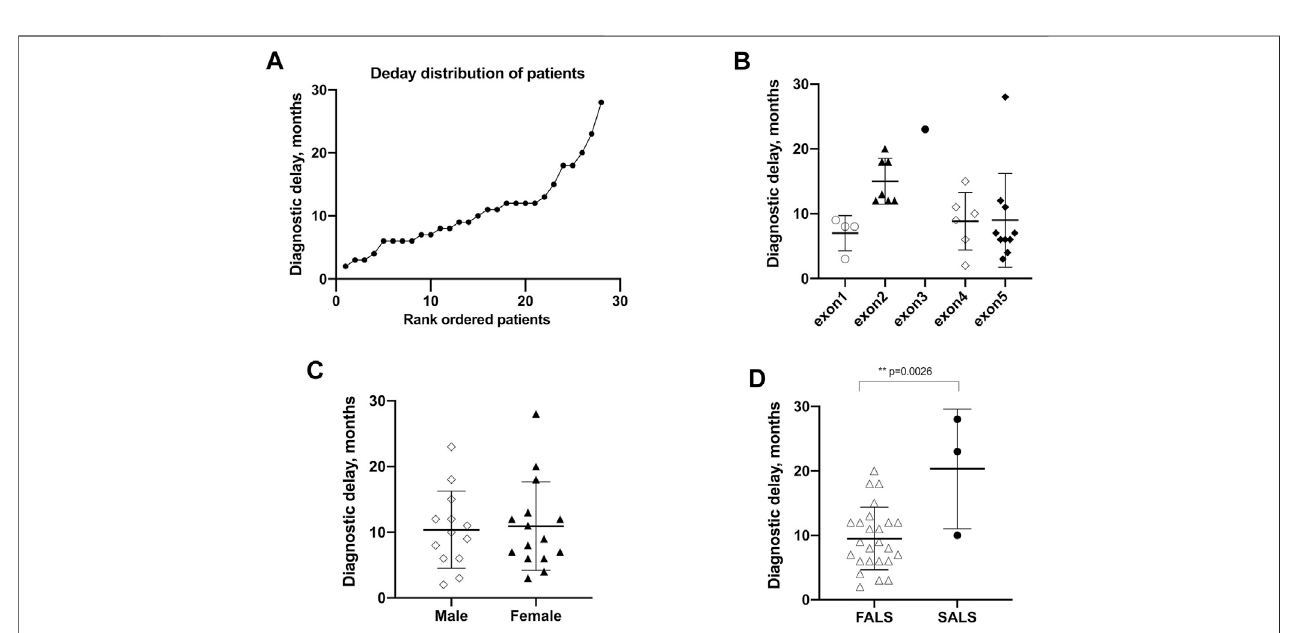
FIGURE3| Diagnosticdelayofpatients with SOD1 mutations. (A) PlotofrankorderedSOD1-mutantpatientsshowingthemedian diagnostic delayof9.5 months (B) Plot comparing the diagnostic delay showed no differences in different exons of SOD1 gene. (C) Plots comparing the diagnostic delay exhibited no differences between male and female patients. (D) plots comparing FALS patients with SALS patients in the diagnostic delay time; neither comparison identi fi ed a signi fi cant difference in AAO ( p (cid:1) 0.58 and 0.15, respectively). FALS patients ( n (cid:1) 25) received an earlier diagnosis than SALS patients ( n (cid:1) 3) [9.5 (4.8) vs. 20.3 (9.3), p (cid:1)